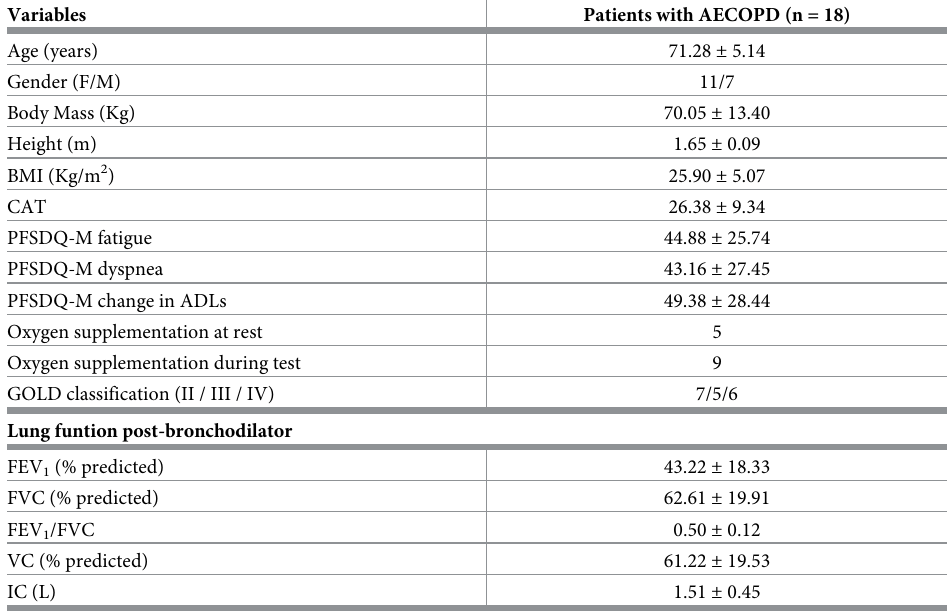
Table 1. Demographic and spirometric characteristics of the study participants. Data are presented by mean ± standard